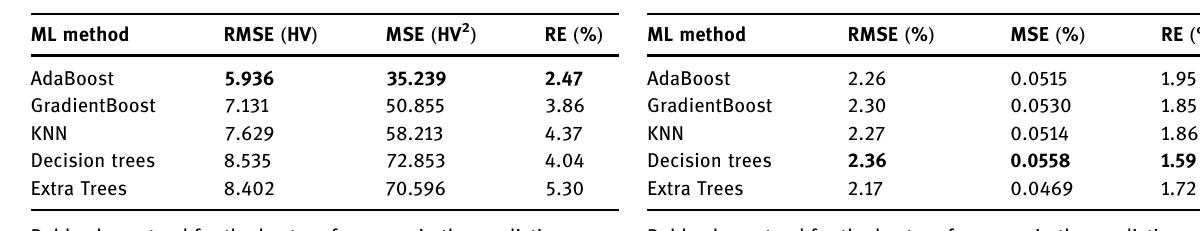
Table 4: Relative mass density prediction performance using dif